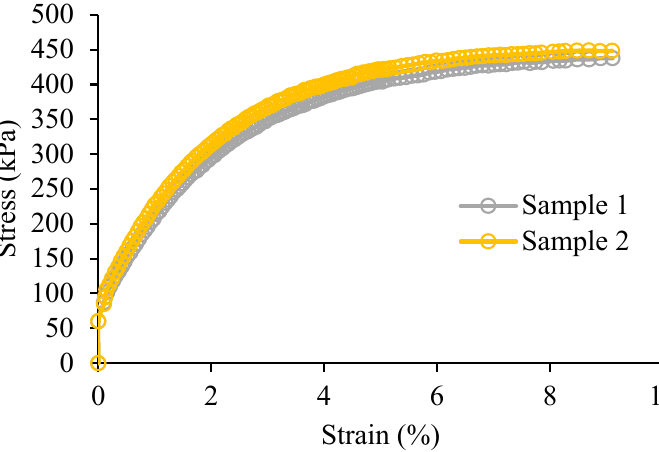
Figure 2. Repeatability tests for fiber-reinforced clays (0.6% PP fiber content).